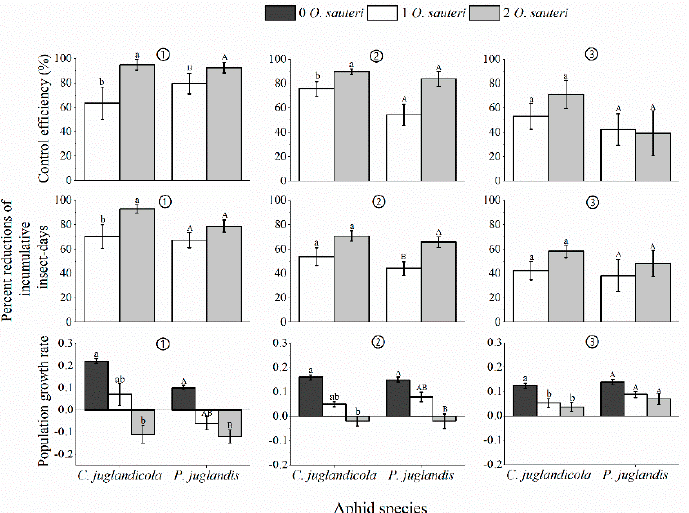
Figure 1. The mean number of aphids in populations of two aphid species exposed to an initial density of 0, 1, and 2 O. sauteri predatory bugs over 15 days. Note: ① indicates the laboratory ex- periments, ② indicates the field experiments, ③ indicates the mix population experiments.